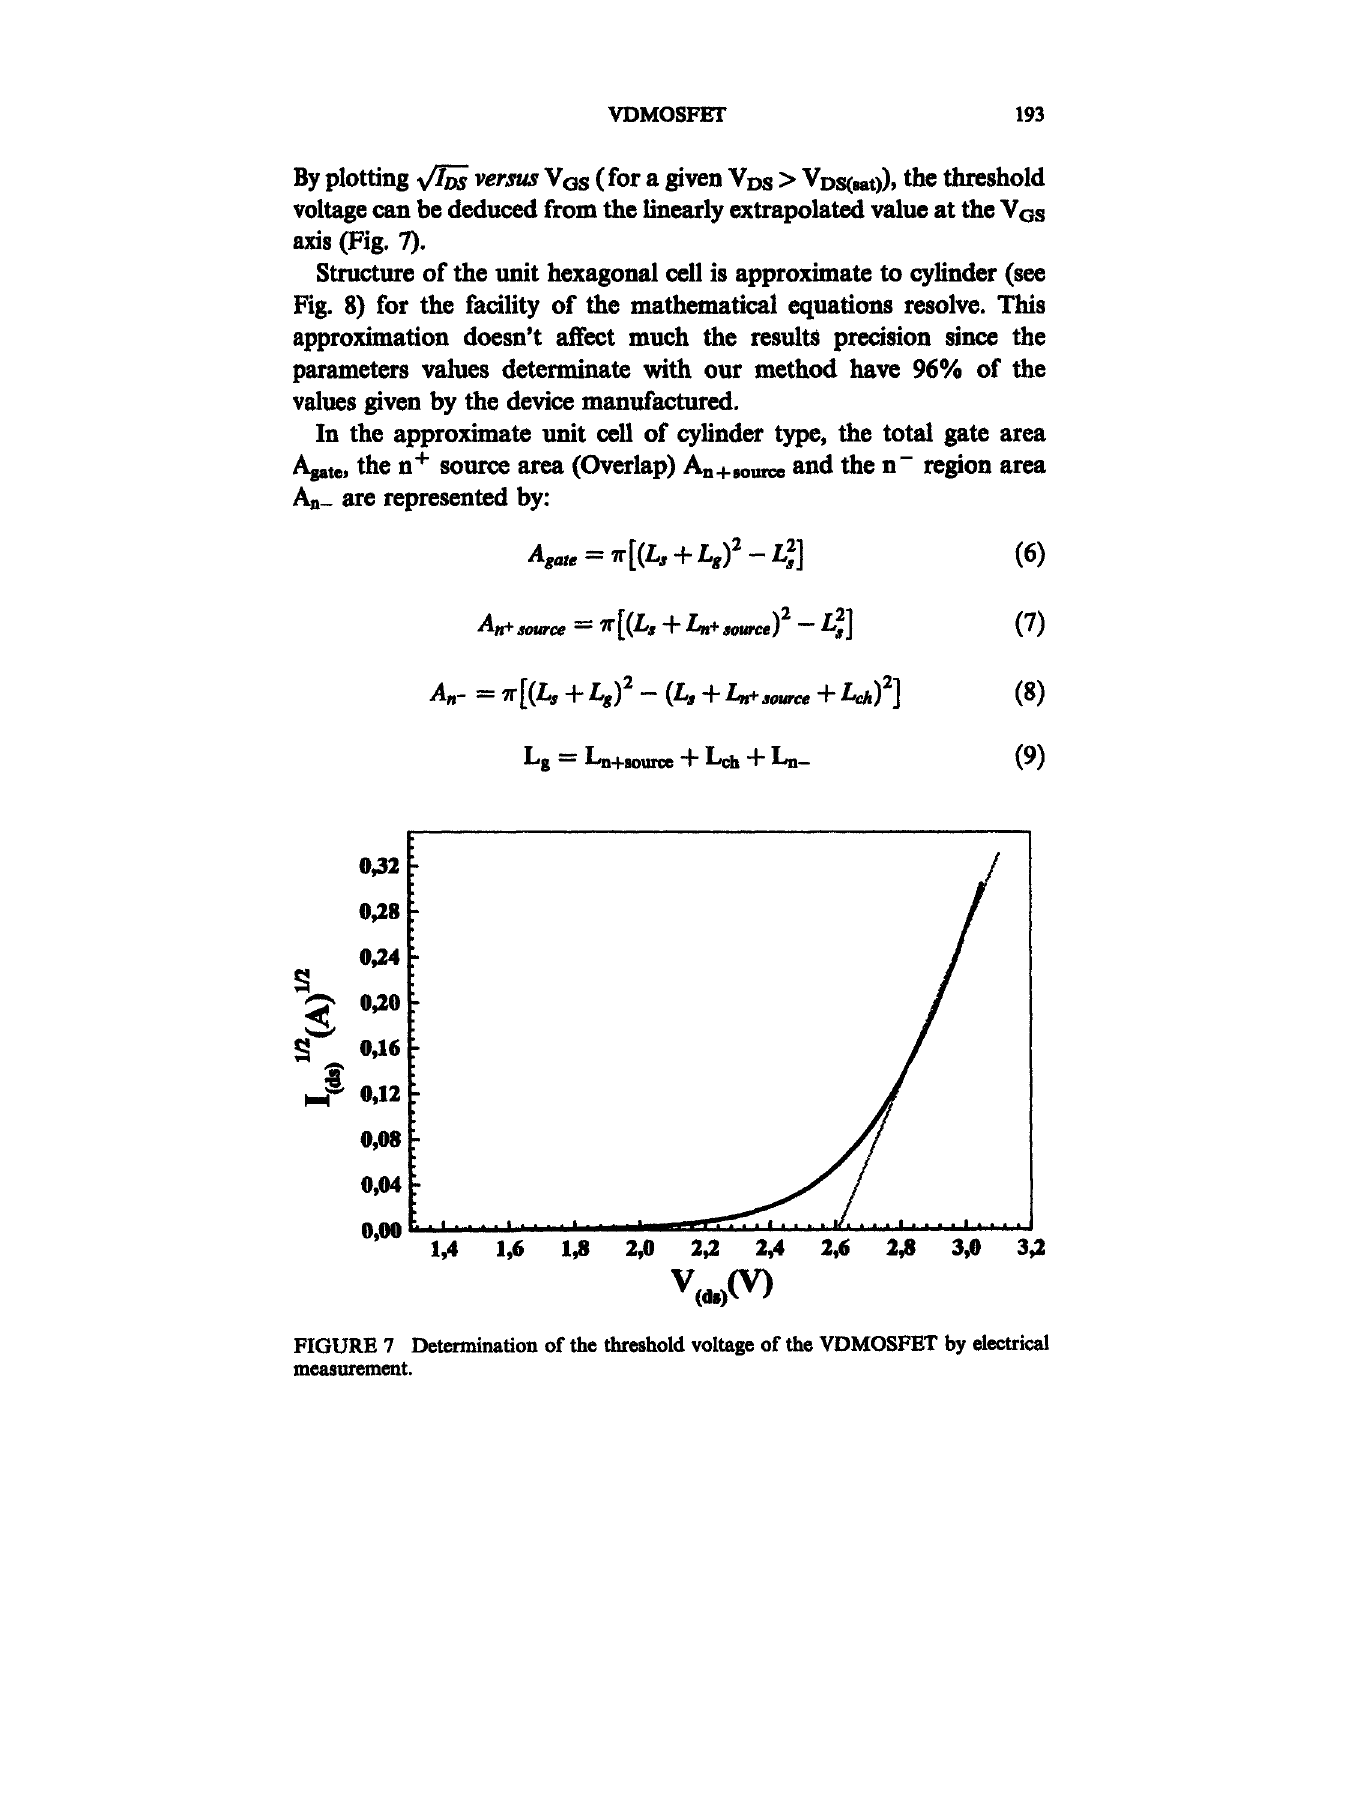
FIGURE 7 Determination of the threshold voltage of the VDMOSFET by electrical